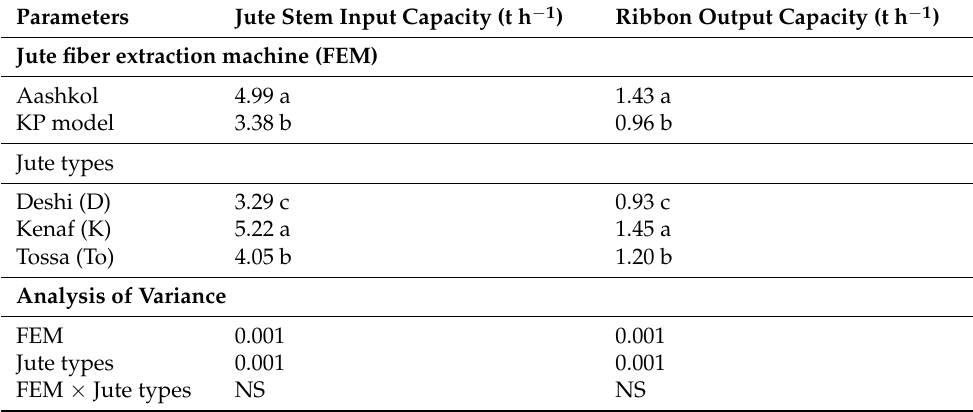
Table 3. Performance of the developed Aashkol and KP model jute fiber extraction machine on different jute types (conducted in the workshop at Rangpur).